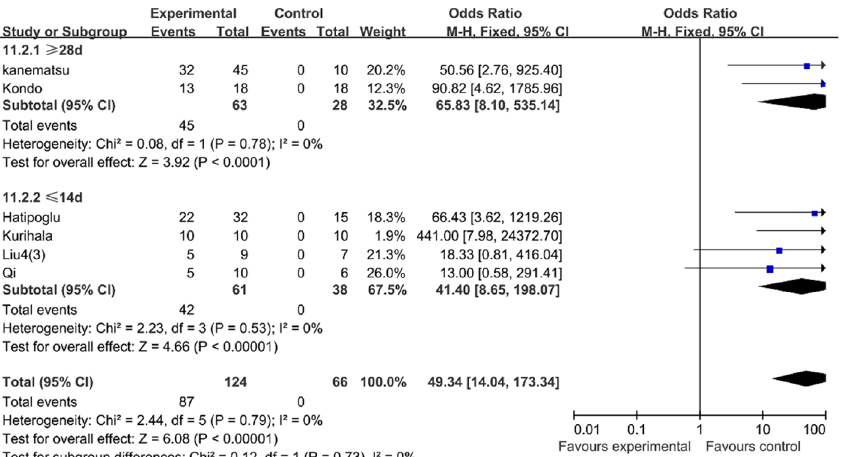
Table 6. In the BAPN group, the mice challenged with AngII longer than 28 days could increase the success rate of AD model compared with the mice challenged with AngII less than 14 days.